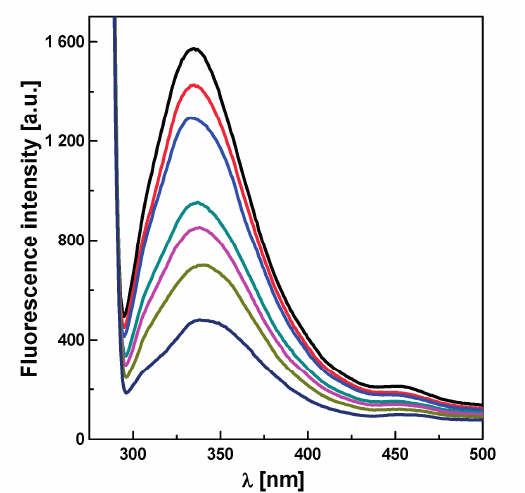
Figure 2. Effect of N ′ -[2,6-dinitro-4-(trifluoromethyl)phenyl]thiophene-2-carbohydrazonoyl chloride on fluorescence of chloroplast amino acids. Compound 3e was added to spinach chloroplasts to a final concentration of 0, 10, 20, 30, 40, 60, 80 μ mol/dm 3 (from top to